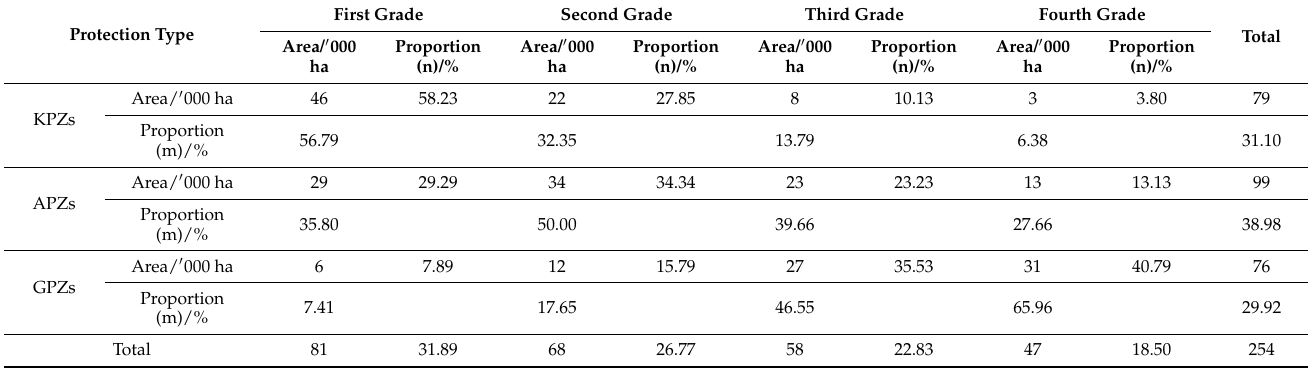
Table 5. Area statistics of forest land quality grades compared with protection